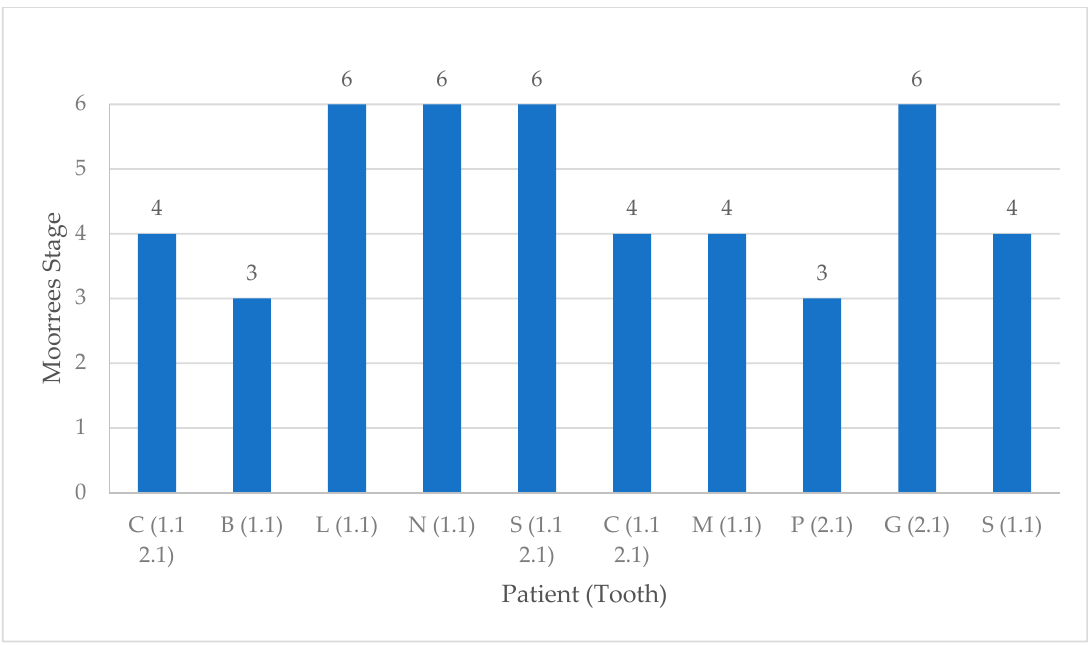
Figure 4. Tooth and root development as assessed at the time of injury using the Moorrees stages. Table 2. The table shows epidemiological and etiological data of the sample.